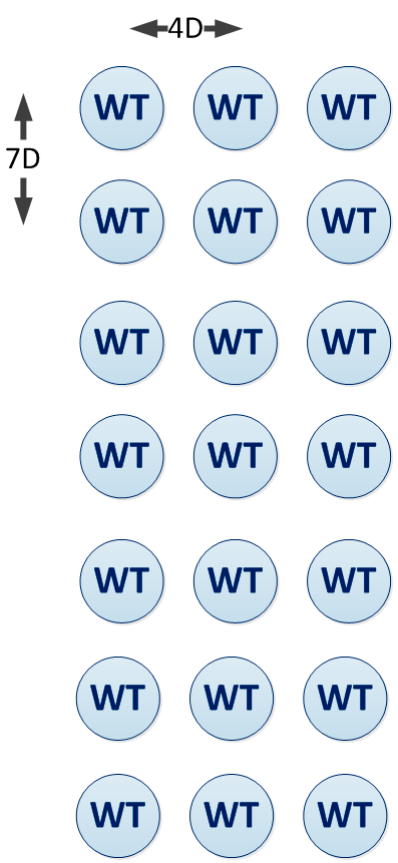
Figure 1. Distance between offshore wind turbines (4D) and distance between lines of offshore wind turbines (7D).